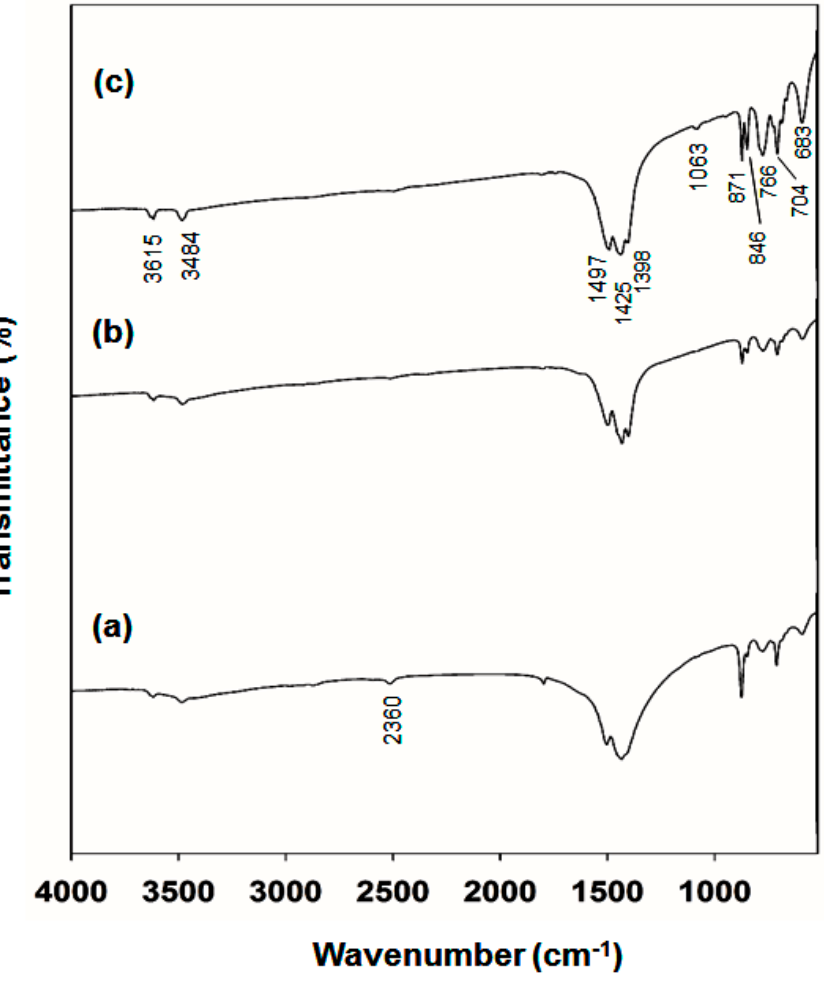
Figure 5. Samples of as-synthesized FTIR spectra ( a ) LC-1, ( b ) LC-2, and ( c ) LC-3.